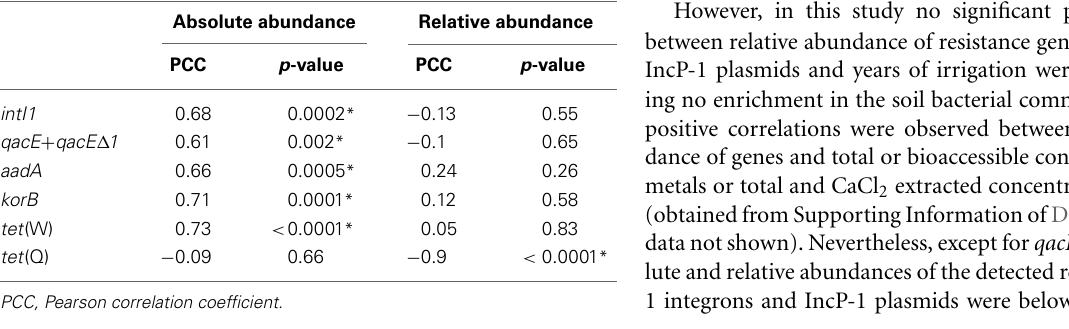
Table 1 | Correlation analysis of absolute (log(gene copies/g dry soil)) and relative (log(gene copies/ rrn copies)) gene abundances in soil samples from the dry season and the duration of wastewater irrigation (1.5–100 years of irrigation; Pearson correlation, p < 0 . 05; significance indicated by asterisk).